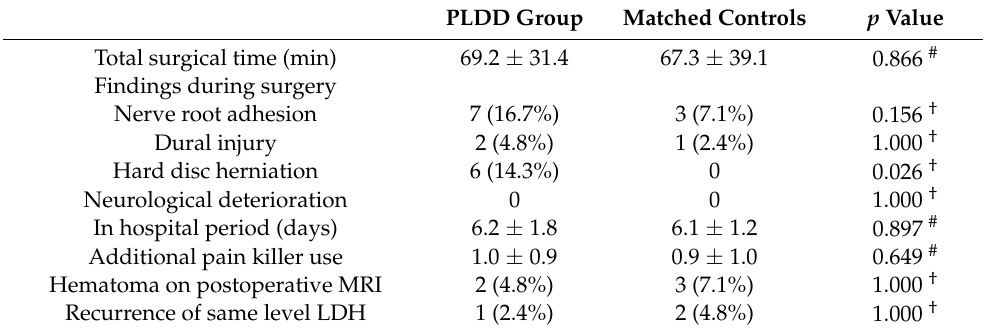
Table 4. Comparisons of surgical data between the PLDD group and matched controls.